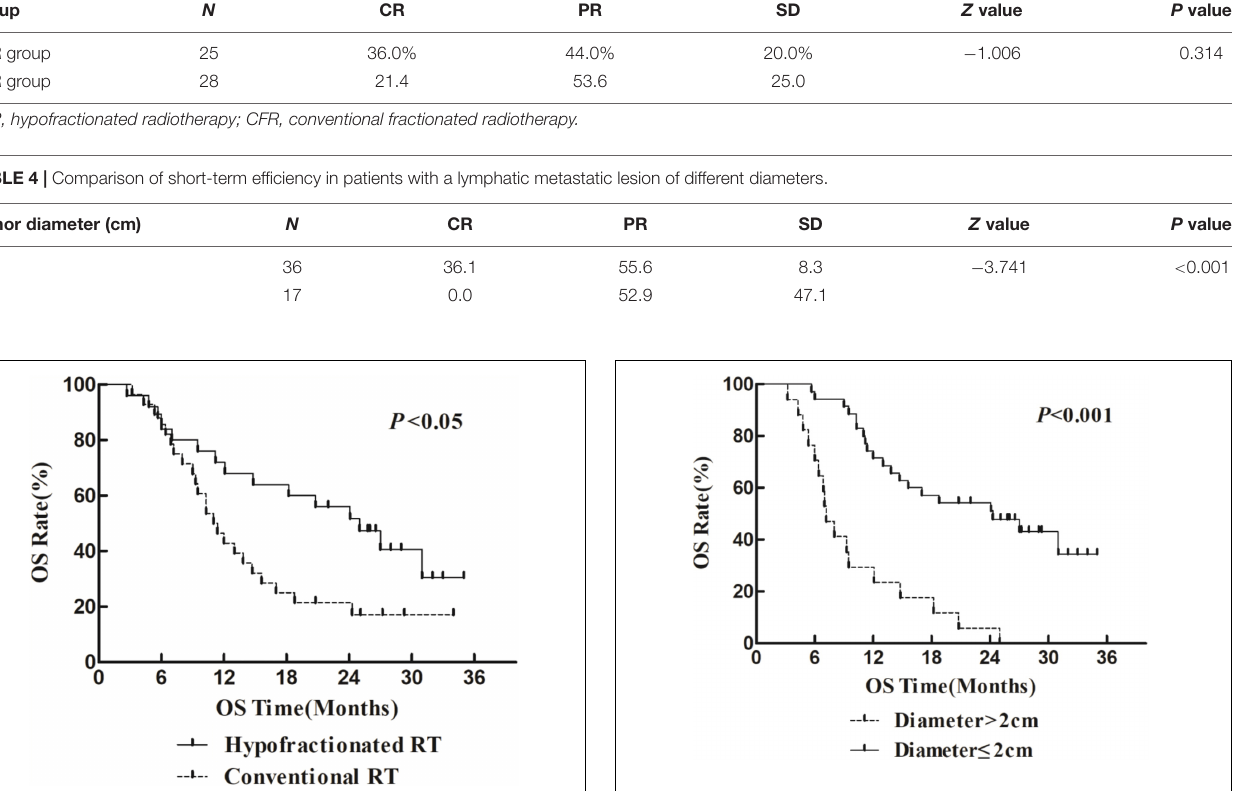
FIGURE 2 | Comparison of OS in patients with various lymph node metastases. Patients with lymph node diameter ≤ 2 cm have better OS than those with > 2